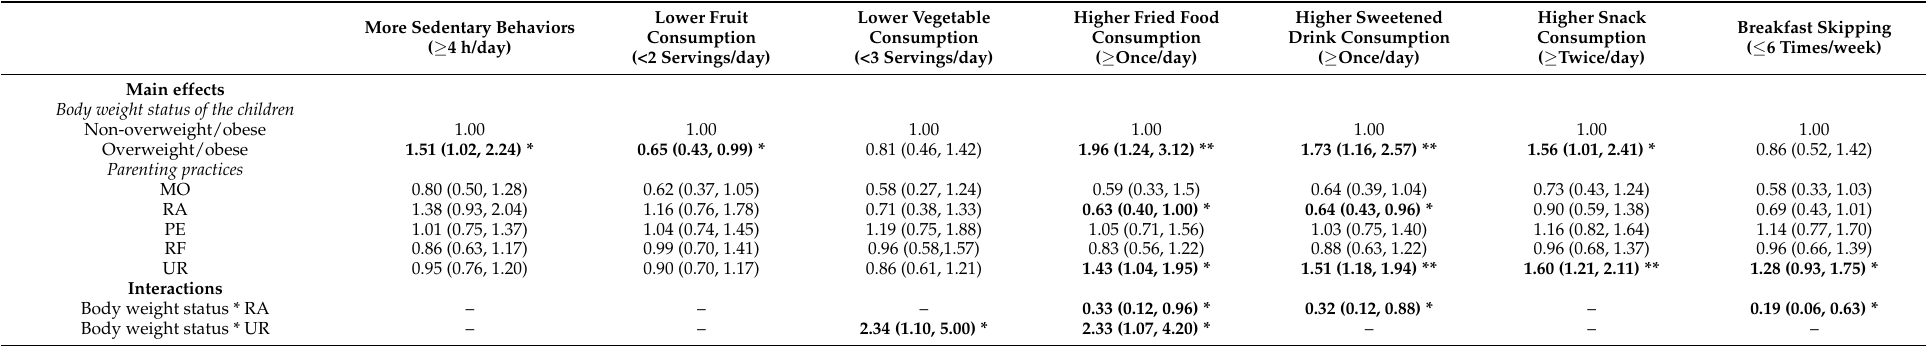
Table 4. Multivariate logistic regression on associations of child body weight status and parenting practices with child unhealthy behaviors (AORs, 95%